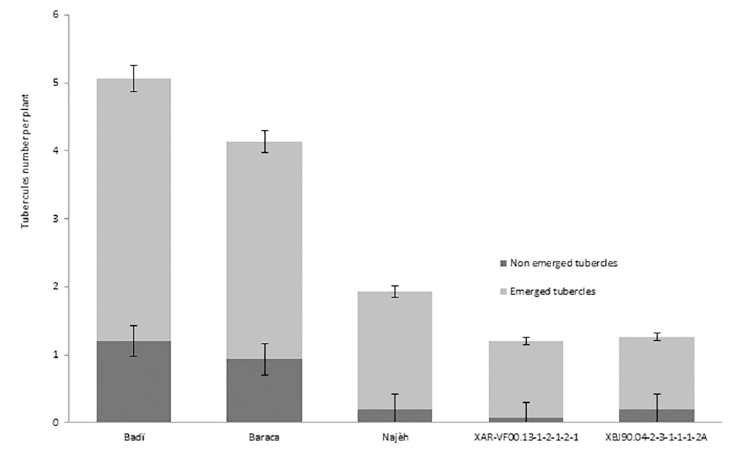
NDOE: number of days from planting to the first Orobanche shoot emergence per plot. Values followed by the same letter column are not significantly different at p = 0.05 (Duncan